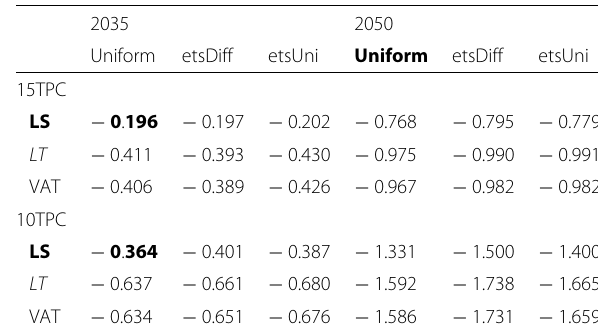
Table 9 Social welfare for different years and scenarios ( ε =